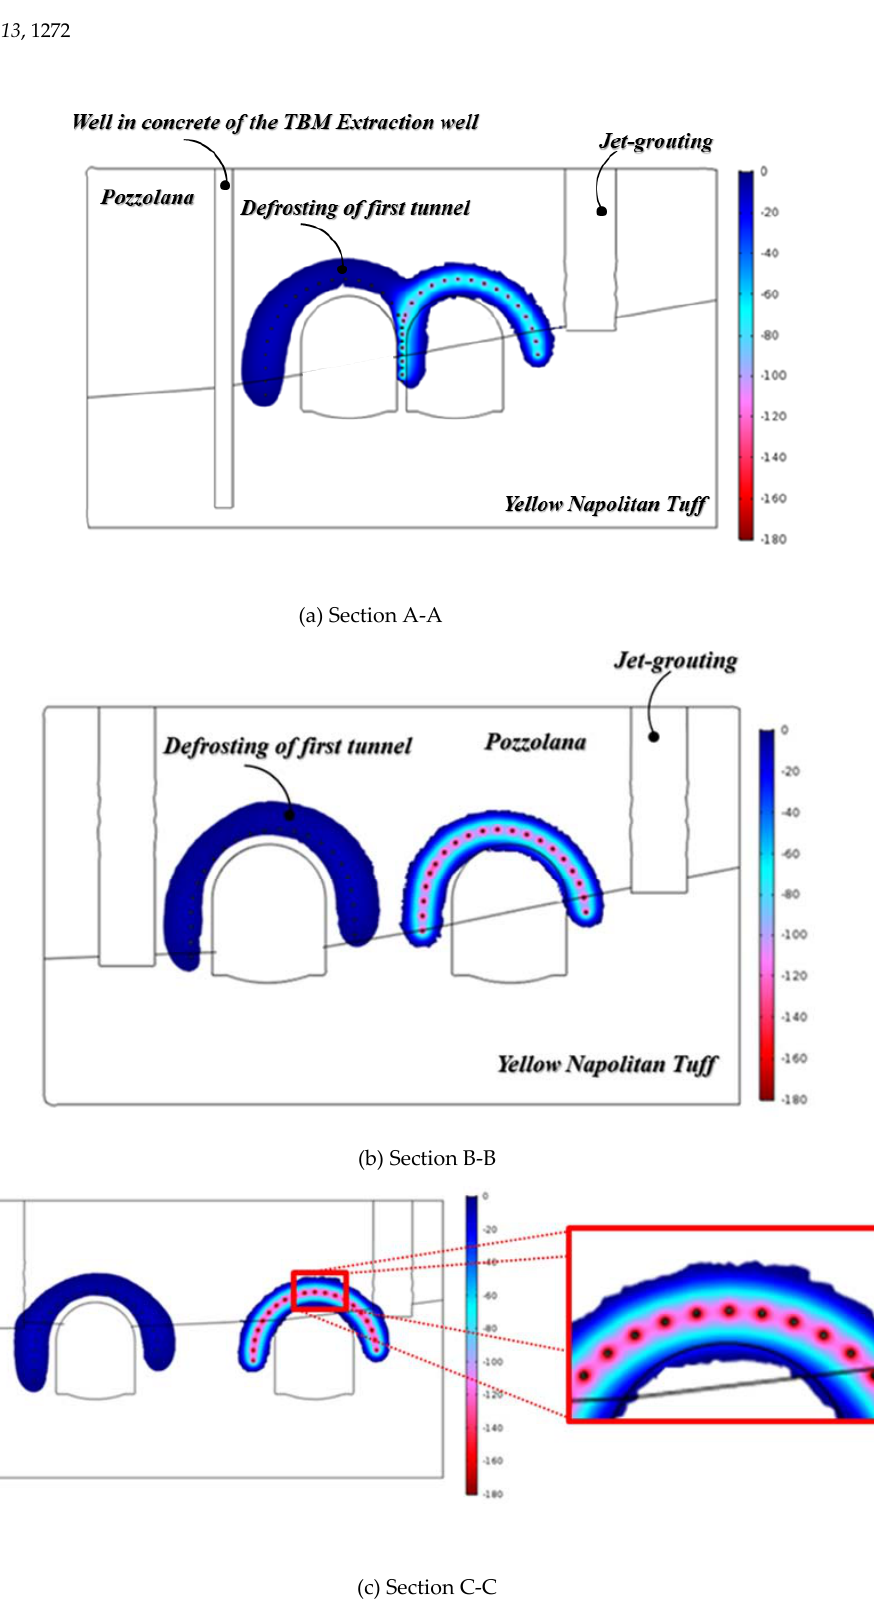
Figure 17. Frozen wall at 0 °C after 14 days.